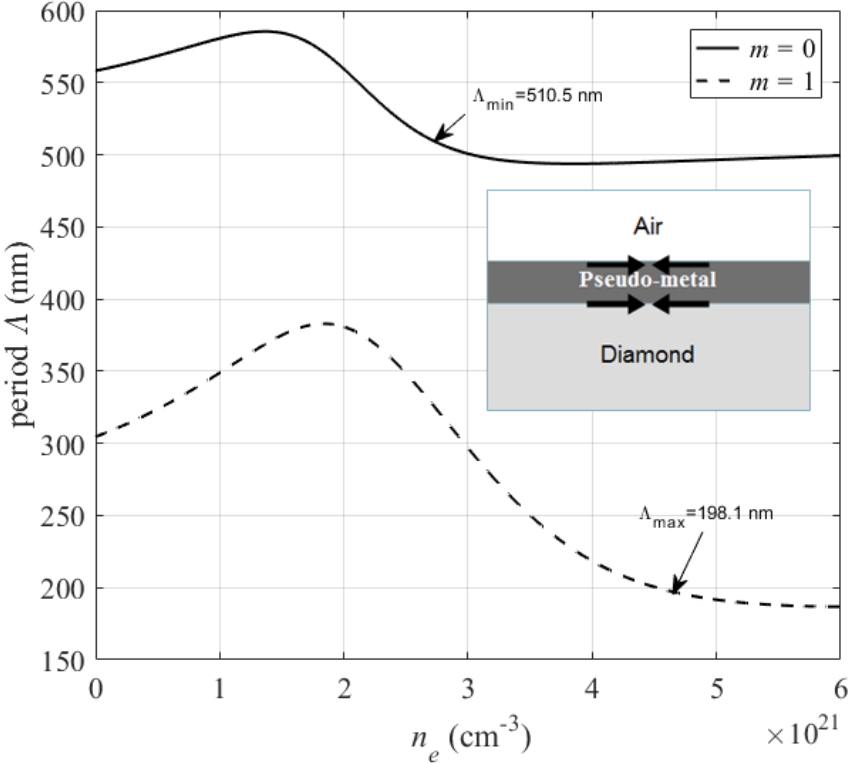
Figure 9. Calculation of LIPSS period evolution as a function of electron plasma excitation at pseudo- metal/air interface ( m = 0 ) and pseudo-metal/diamond interface ( m = 1 ) under fs-laser irradiation at 1030 nm wavelength. Optical system modeled as a pseudo-metal layer surrounded by the original material (diamond) and air is shown in the